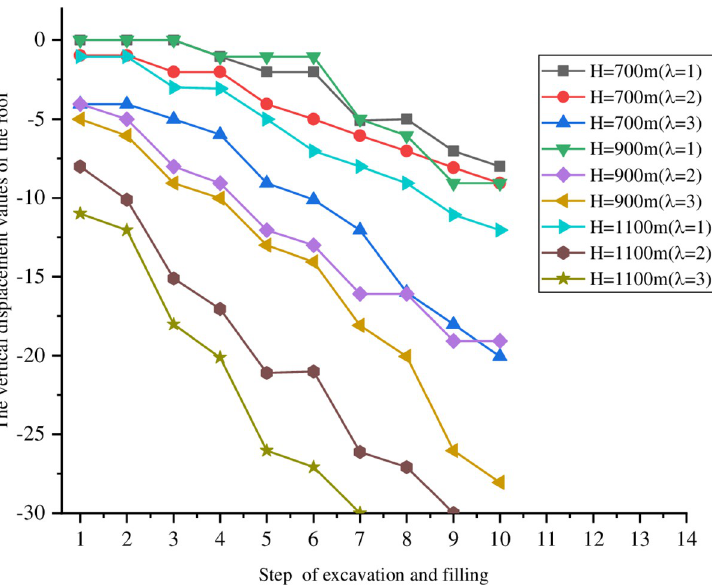
Fig 4. Vertical displacement of the monitoring points on the roof at different